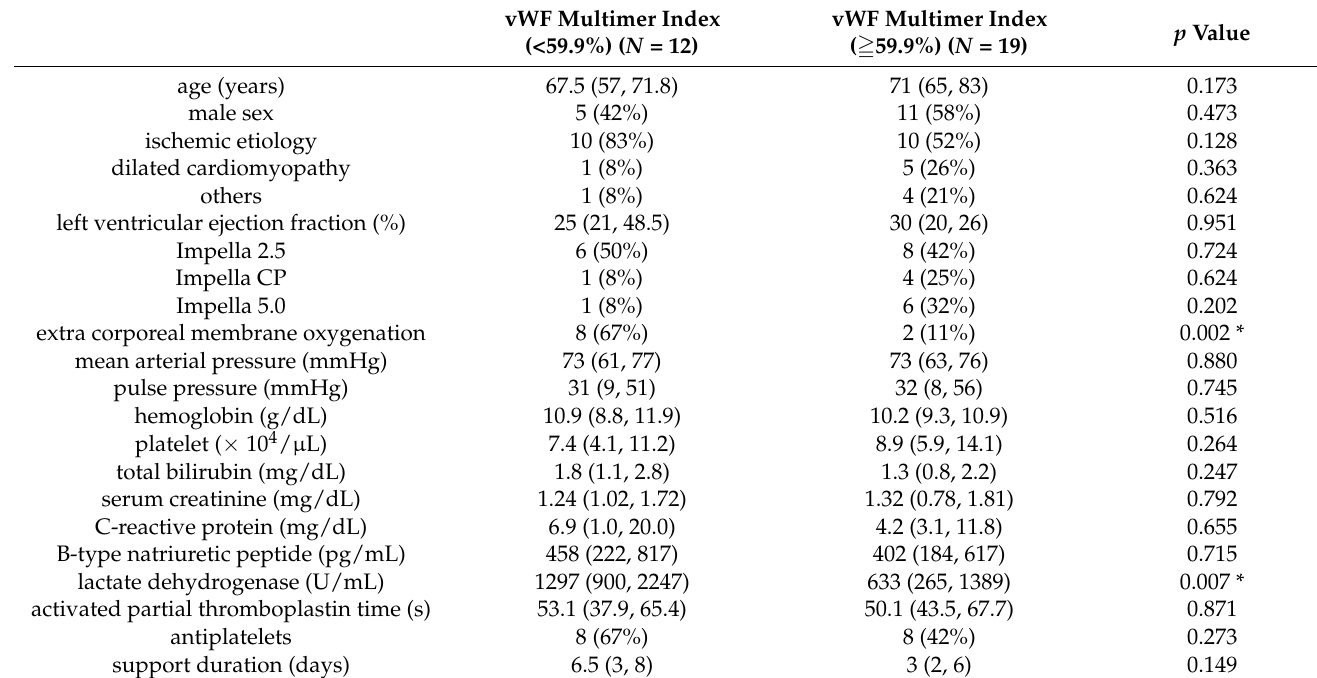
Table 4. Association between low vWF large-multimer index group and other clinical